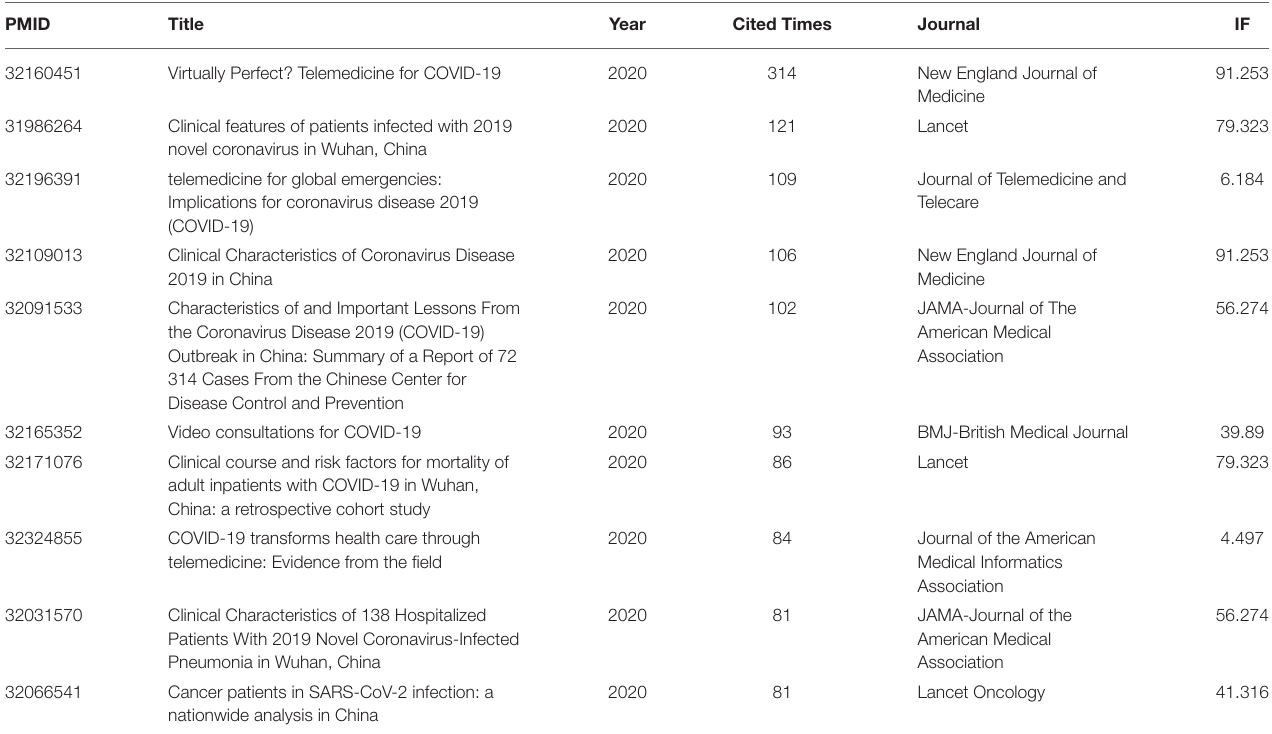
TABLE 2 | Top 10 cited references in telemedicine research in COVID-19.